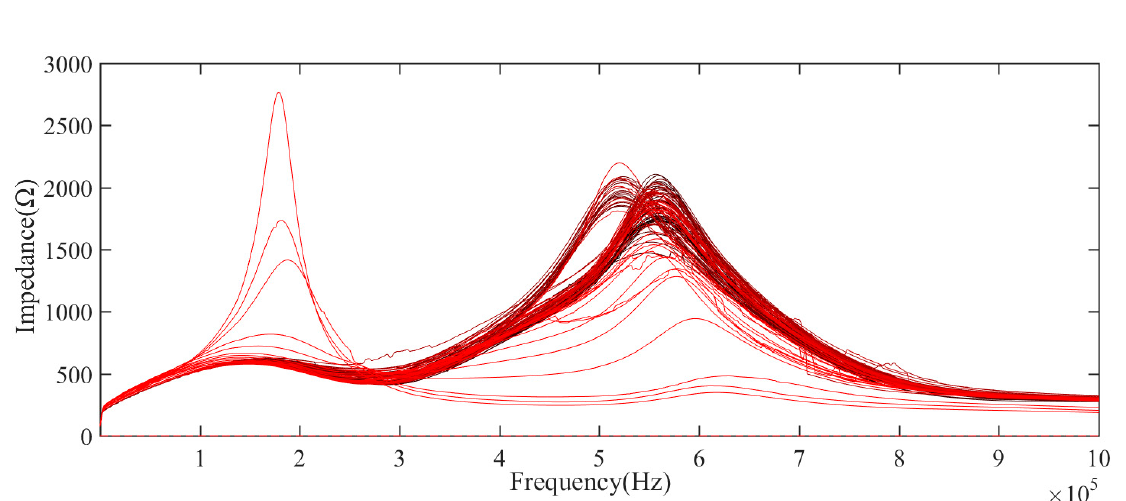
Figure 4. The measurement value of impedance spectra of the electromagnetic coil in the whole life.